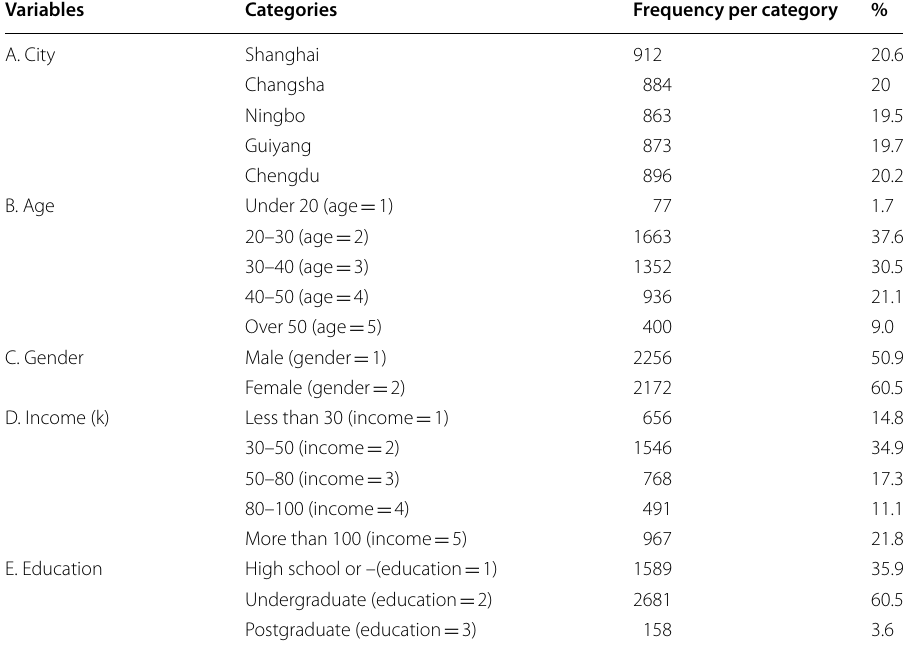
Table 1 Sample description (total